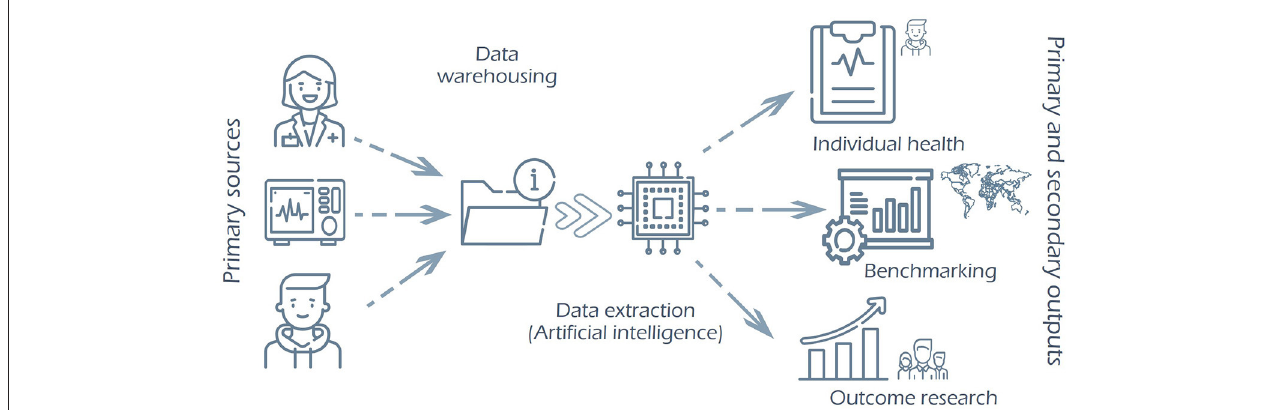
FIGURE 3 | Expected evolution of the Health Information System (HIS). From the primary sources (clinician, diagnose or treatment machines, patients), data is warehoused in a central repository of information, normalized and standardized within an international standard. Thus, the data inside is shareable for multiple purposes, such as patient follow-up, benchmarking, or outcome